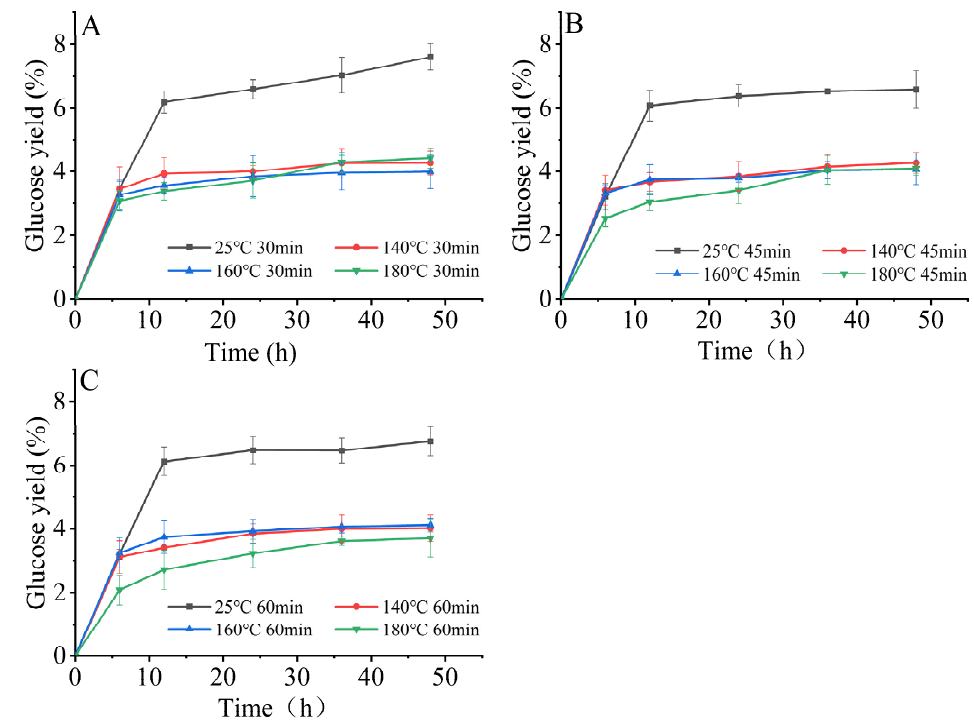
Figure 5. Effect of HTE conditions on the glucose yield after enzymatic hydrolysis for 48 h in the second stage. (Figure 5A: 30 min with different temperature of THE, Figure 5B: 45 min with different temperature of THE, Figure 5C: 60 min with different temperature of THE)